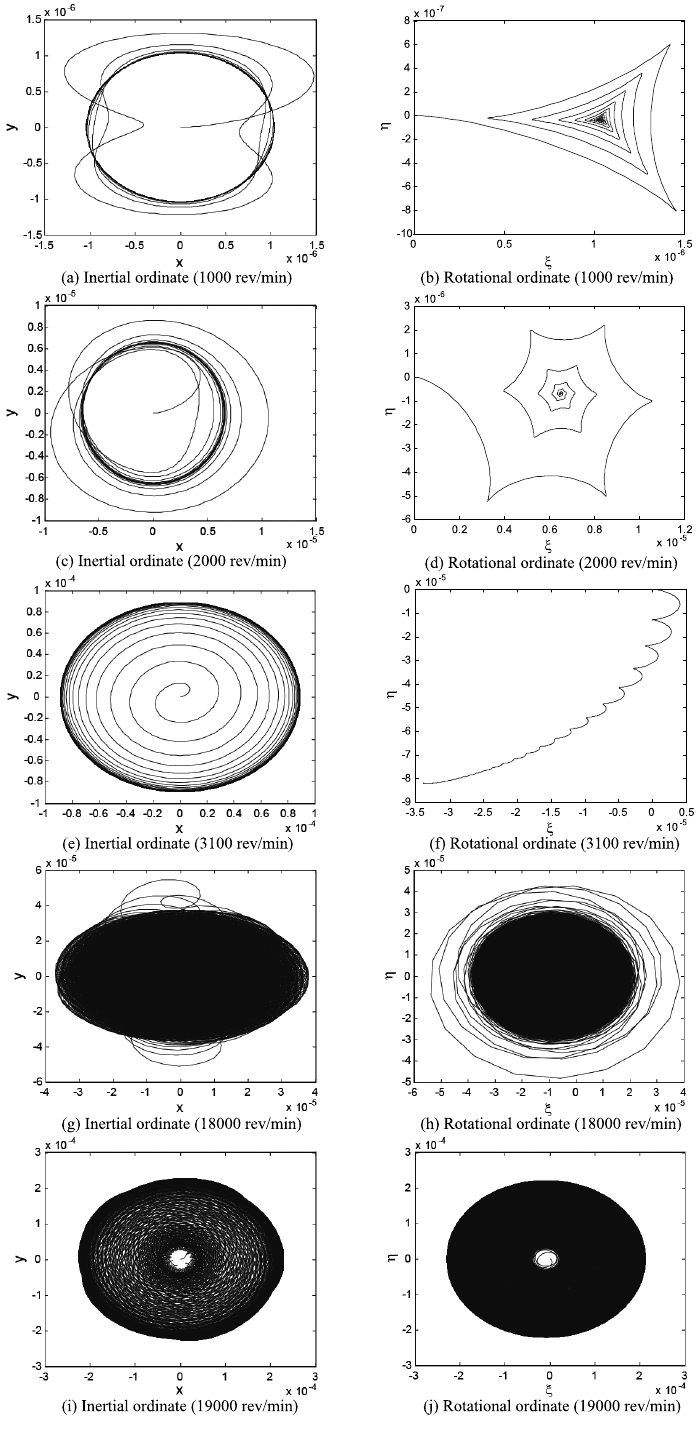
Fig. 9. Locus of axis centre of the soft suspension